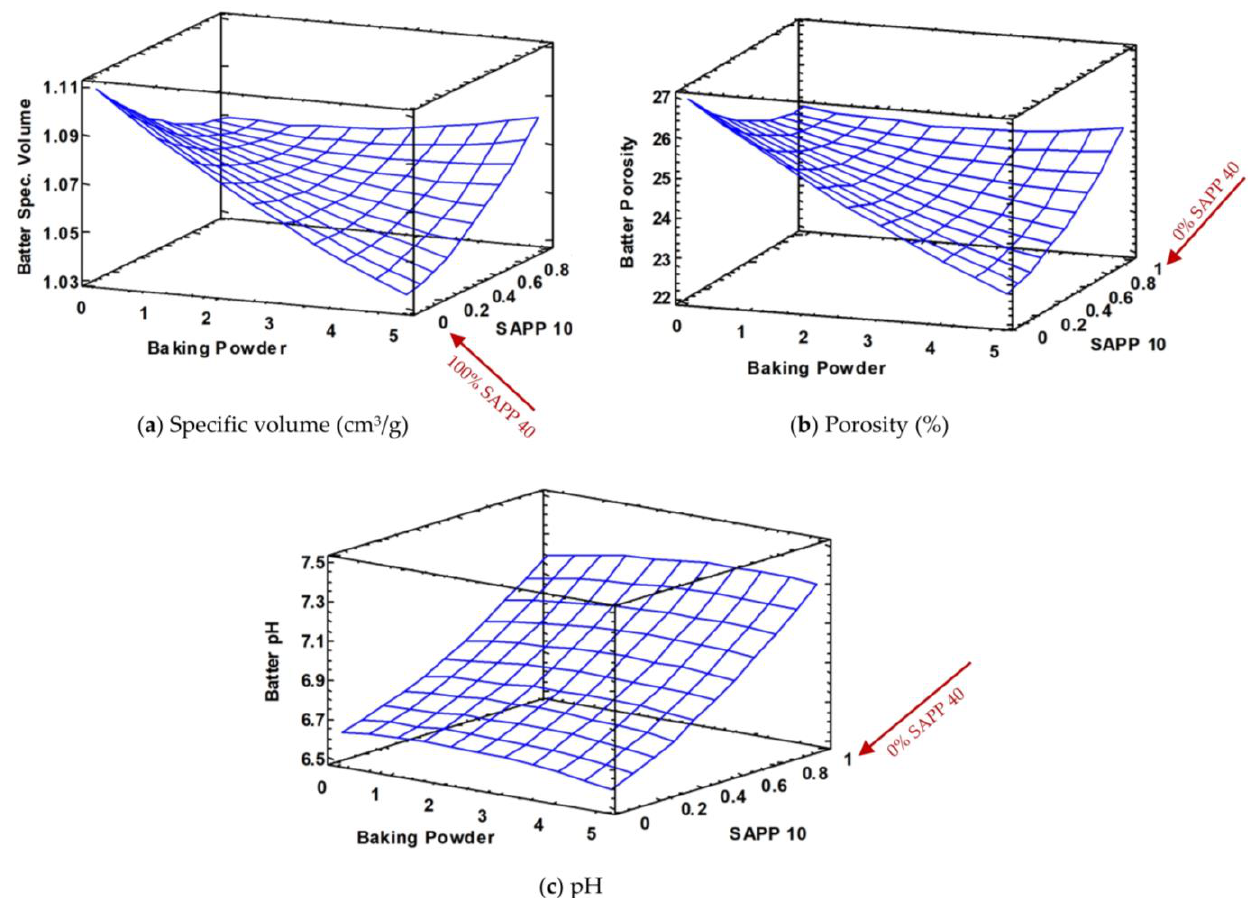
Figure 2. Response surfaces of batter specific volume ( a ), porosity ( b ) and pH ( c ) with respect to baking powder (BP) and sodium acid pyrophosphate (SAPP) levels (red arrow indicates SAPP 40 is the inverse of SAPP 10).